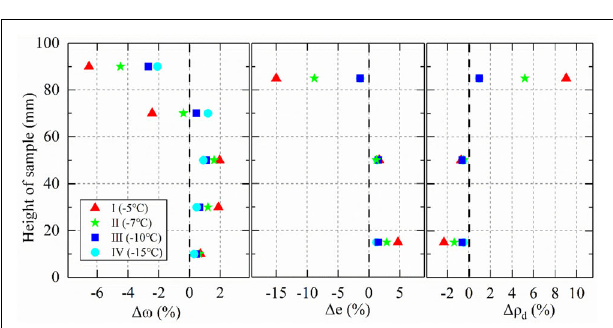
FIGURE 6 | Moisture content, void ratio, and dry density variation along the specimen height after freeze-thaw experiments under four freezing